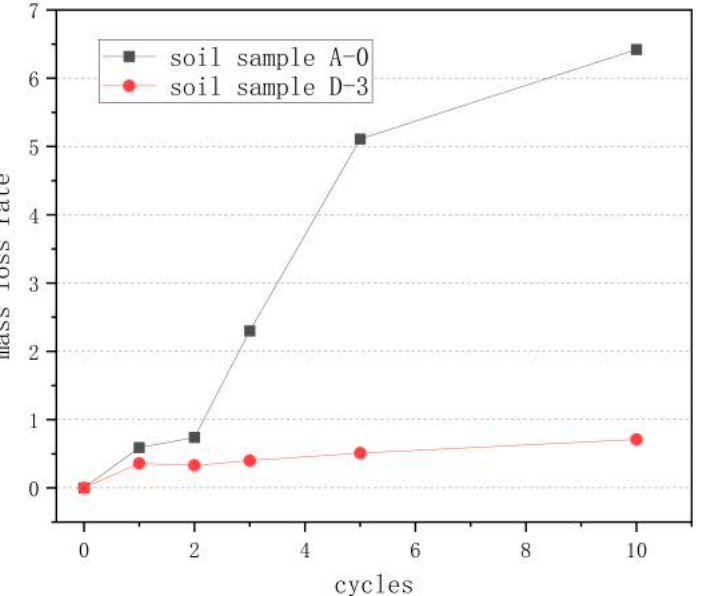
Figure 6. Variation of mass loss rate of soil samples in groups A-0 and D-3 with the number of cycles.